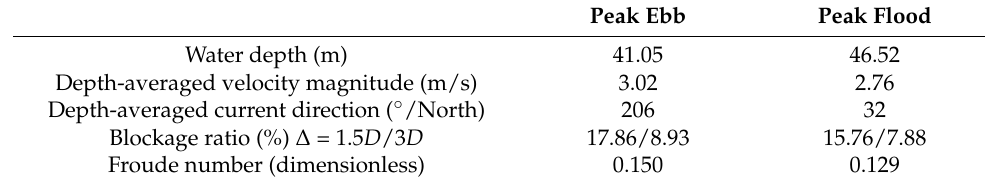
Table 1. Characteristics of the flow during peak ebb and flood in the center of the fence (49 ◦ 42.300 (cid:48) N; 2 ◦ 6.180 (cid:48) W) without the effects of turbines. ∆ corresponds to the lateral spacing between devices (1.5 D or 3 D ). The blockage ratio is equal to the surface area swept by the blades ( π D 2 /4 ) divided by the cross-section of the flow, that is to say the water depth multiplied by the distance between two consecutive turbines (1.5 D or 3 D